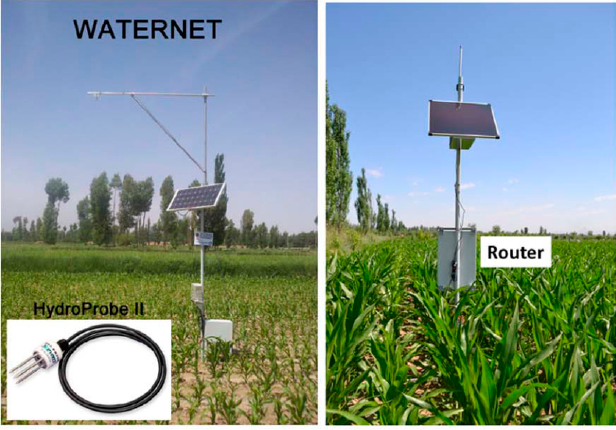
Figure 2. Sensor node and router of the wireless sensor network.